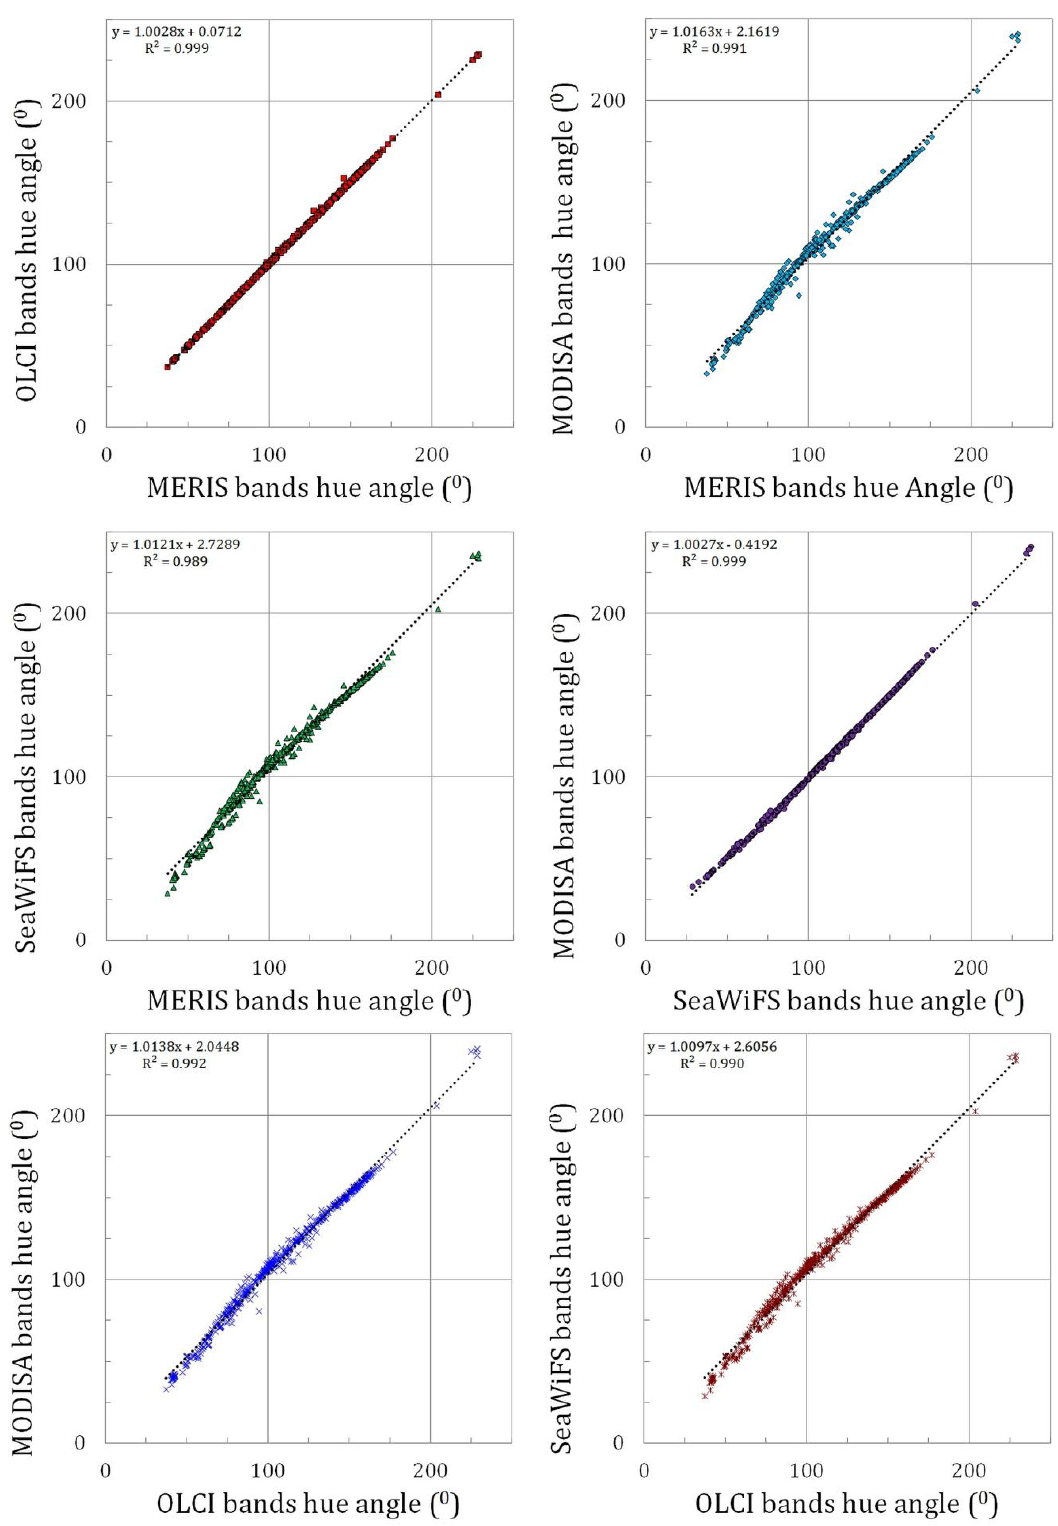
Figure 8. Inter-comparison of the hue angle (“the colour”) reconstruction of four ocean colour satellite sensors. Dotted lines give the best linear fit to the